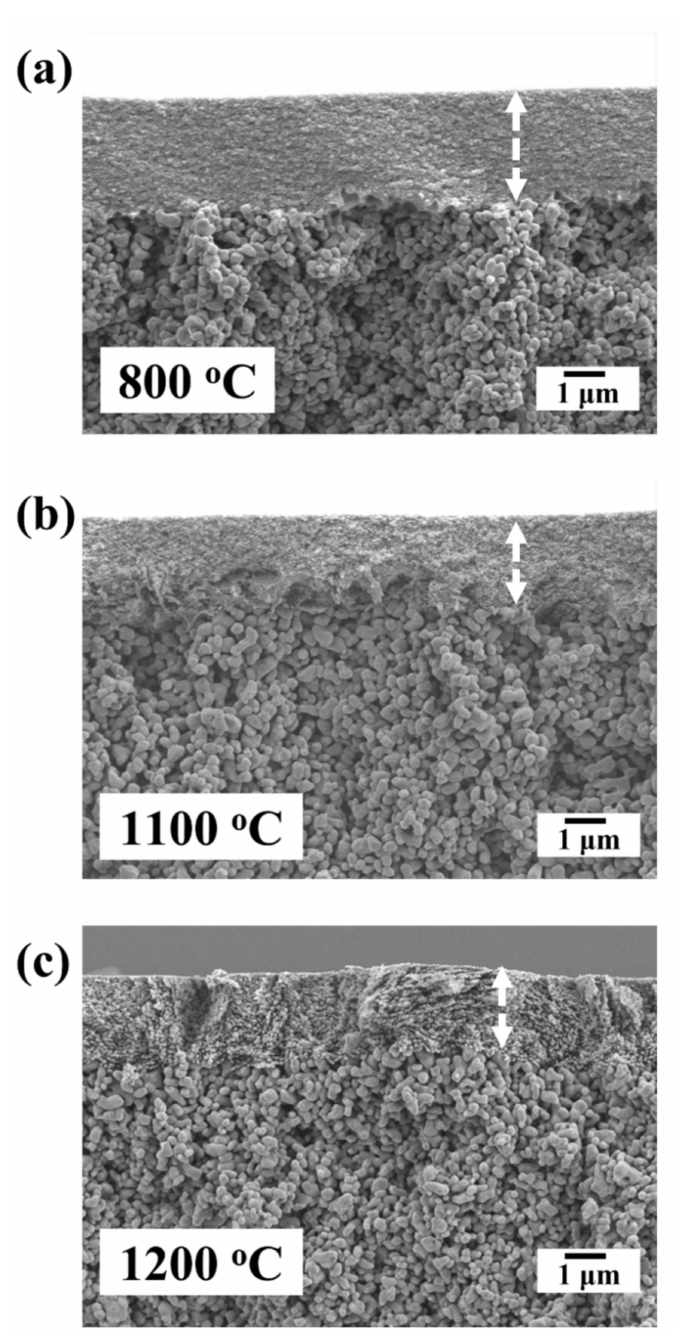
Figure 6. Cross-sectional SEM micrographs of the Al 2 O 3 ultrafiltration (UF) membranes; ( a ) γ -Al 2 O 3 membrane sintered at 800 ◦ C, ( b ) α -Al 2 O 3 membrane sintered at 1100 ◦ C, ( c ) α -Al 2 O 3 membrane sintered at 1200 ◦